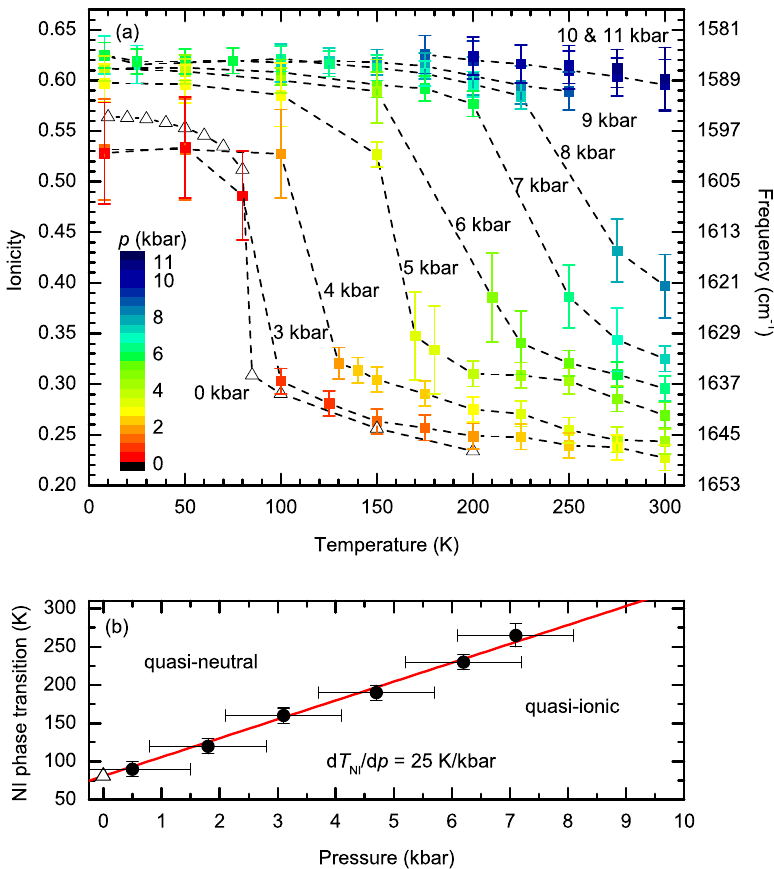
Figure 4. ( a ) Temperature dependence of the ionicity ρ of TTF-CA at different hydrostatic pressure. The labels designate the value of pressure at room temperature, while the lines follow separate cooling runs from room temperature to T = 10 K. The color of the points gives the corrected pressure as shown by the legend. The empty triangles represent separate ambient-pressure measurements on a single crystal. The quasi-ionic phase is defined by an ionicity ρ > 0.5; ( b ) Phase diagram of TTF-CA as obtained from optical measurements of the vibrational peaks. The transition temperature under applied pressure (circle) increases by 25 K/kbar, starting from the T NI = 81 K at ambient pressure (triangle). Note that the pressure values shown here are corrected for the losses by thermal contraction (adapted from Ref.